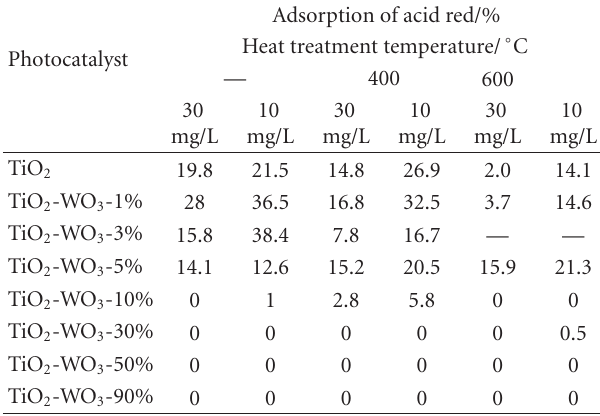
Table 2: Adsorption of AR on the photocatalysts